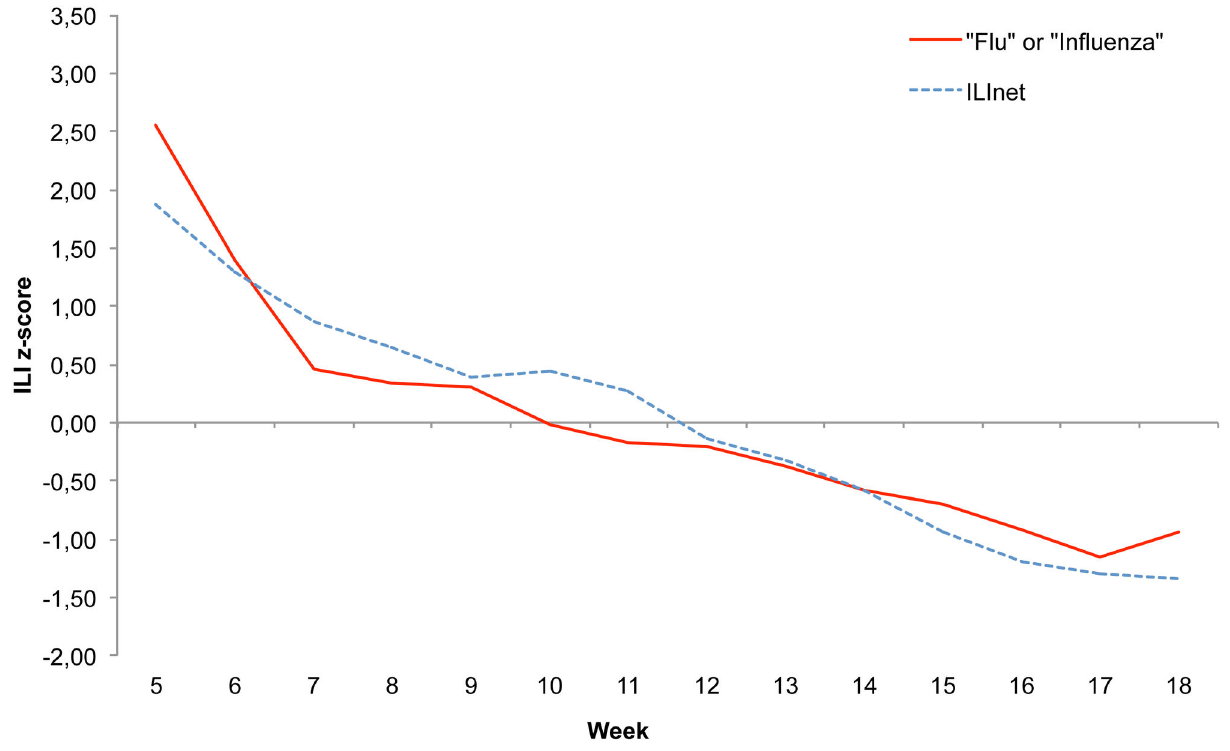
Figure 3. Weekly reported ILI (CDC) and tweets including the words “flu” or “influenza”. The blue line represents in all graphs the z-scores of CDC’s reported ILI for the 14-week period starting in week 5 (January 2013) through week 18 (May 2013). The red line represents the z-scores of tweets including the words “flu” or “influenza”, geolocalized with the extended narrow localization